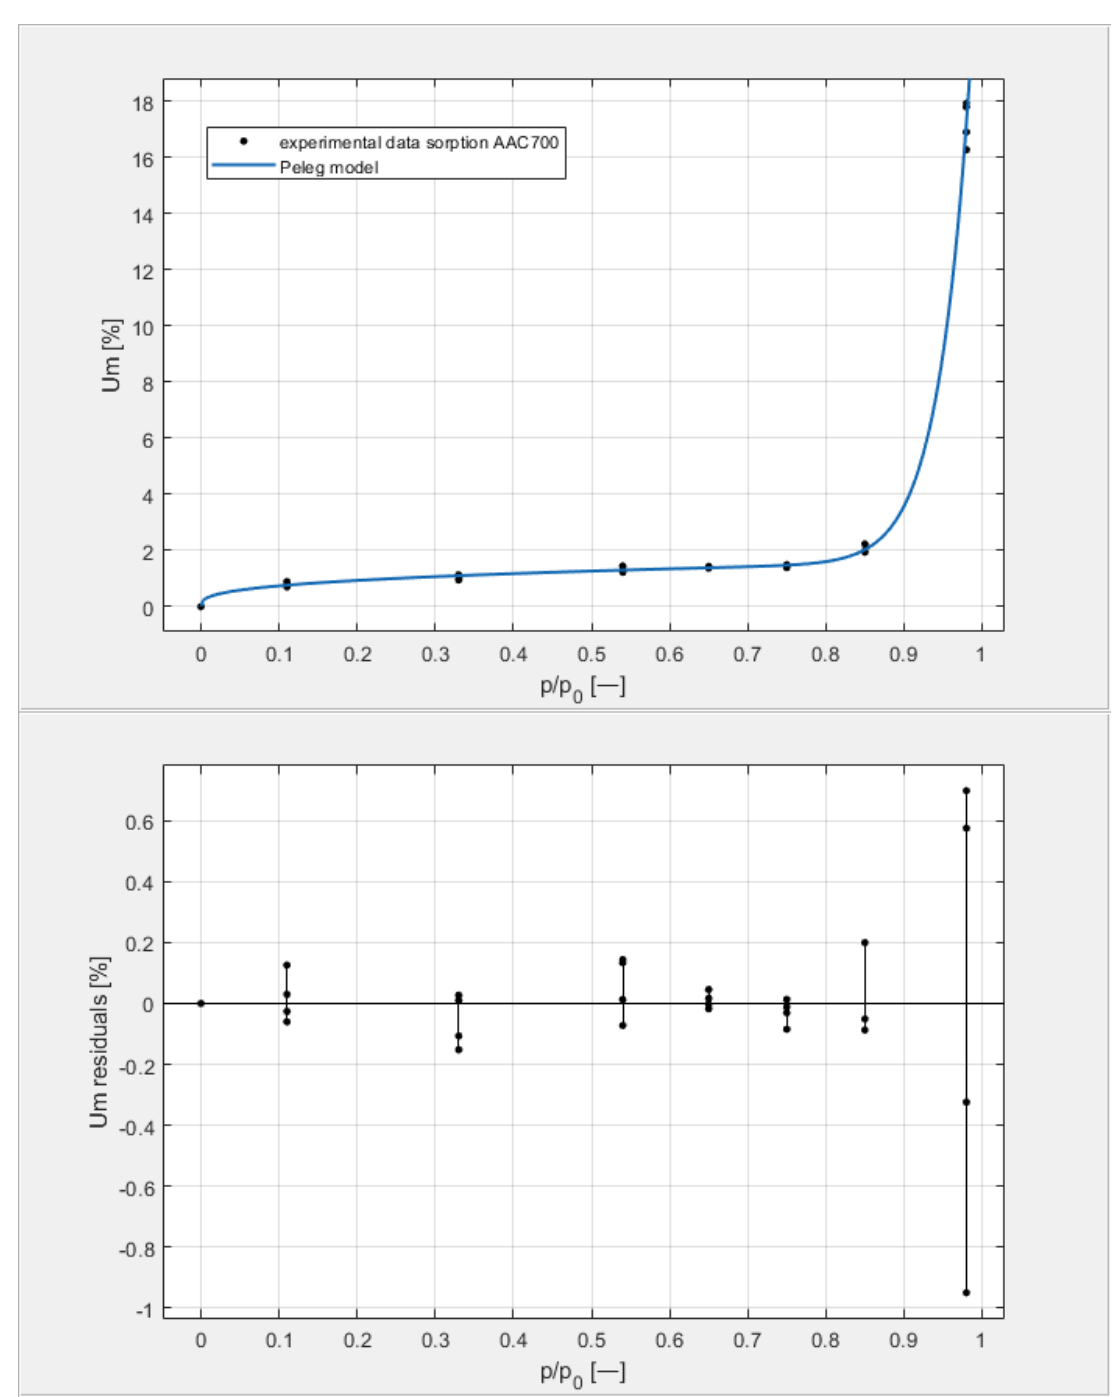
Figure 12. The sorption isotherms of class 700 aerated concrete described by the Peleg equation, plotted with the approximation error.